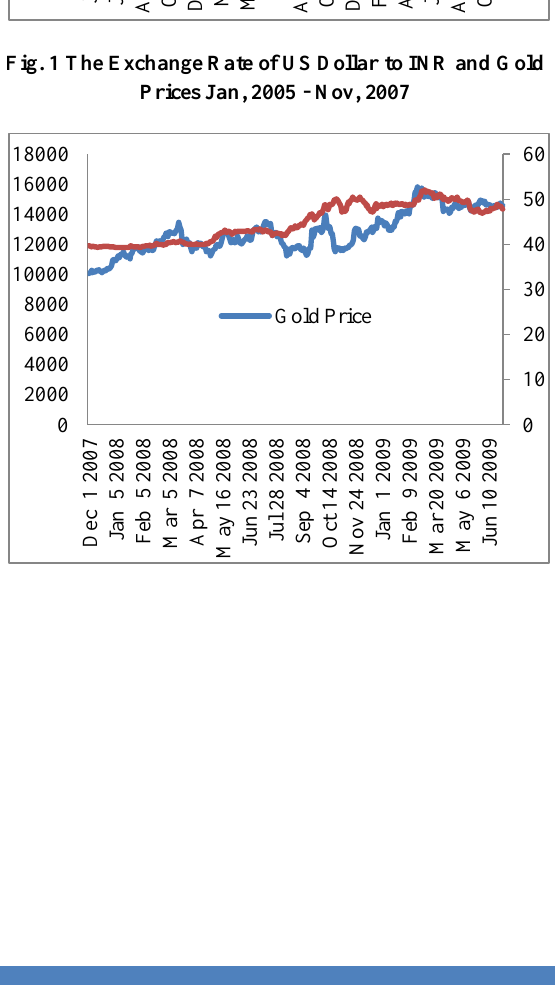
Fig. 2 The Exchange Rate of US Dollar to INR and Gold Prices July, 2009 – Dec, 2013